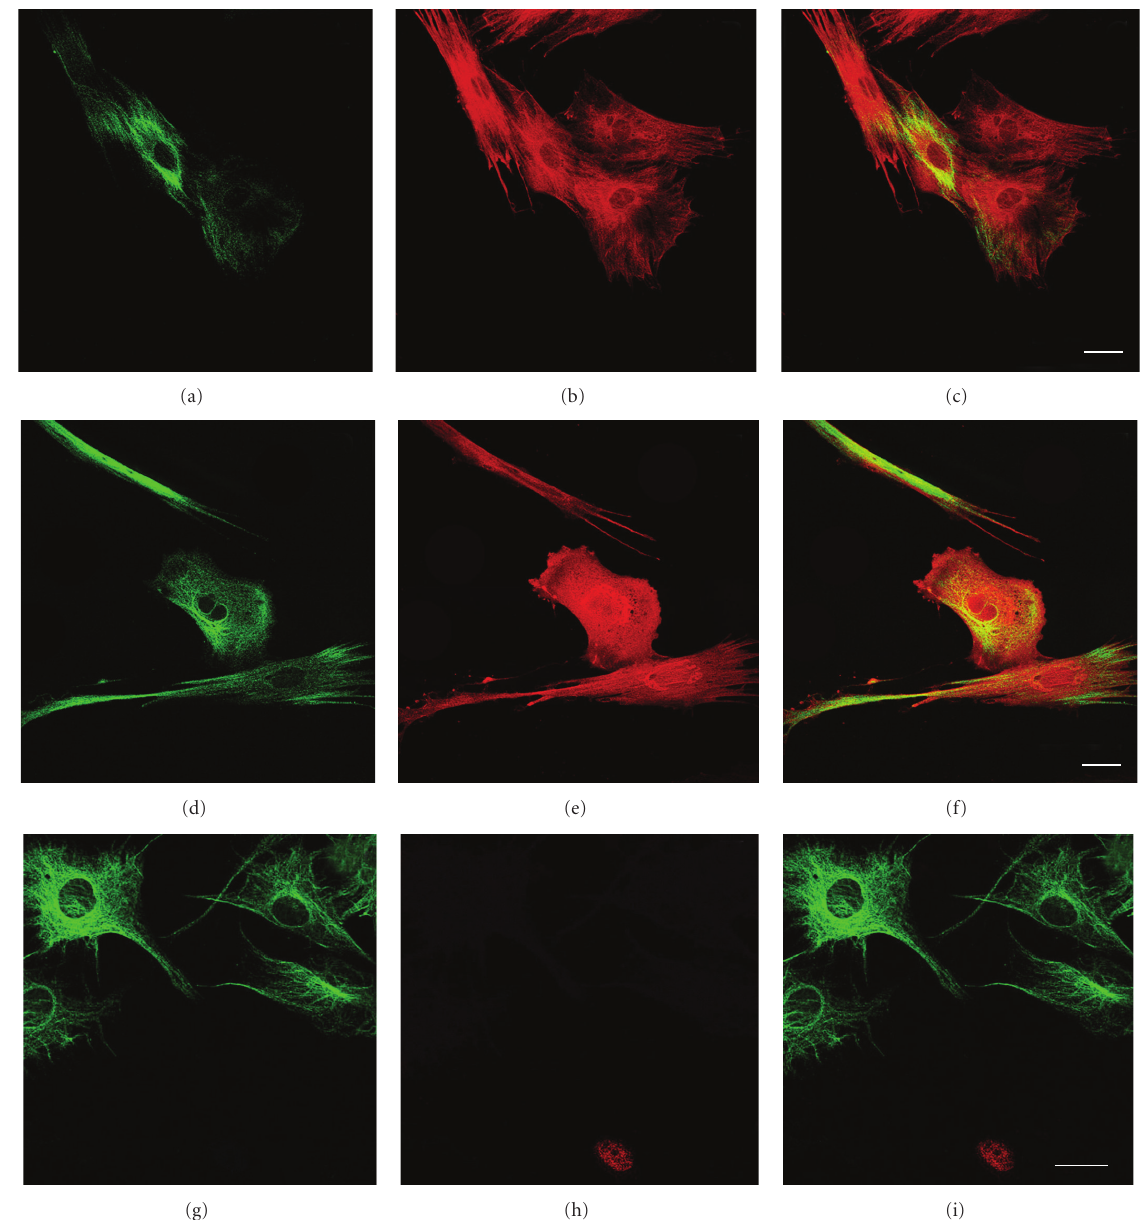
Figure 6: Spontaneous coexpression of neural markers by undi ff erentiated rMSCs (P4) after 14 days of culture. Nestin was labelled in green (a, d, and g), and the other neural markers in red: β III-tubulin (b); GFAP (e); NeuN (h). Merges (c, f, and i). Bars: 50 μ m.